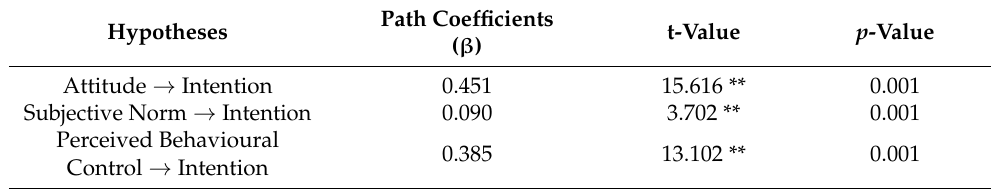
Table 4. Results of the TPB model.